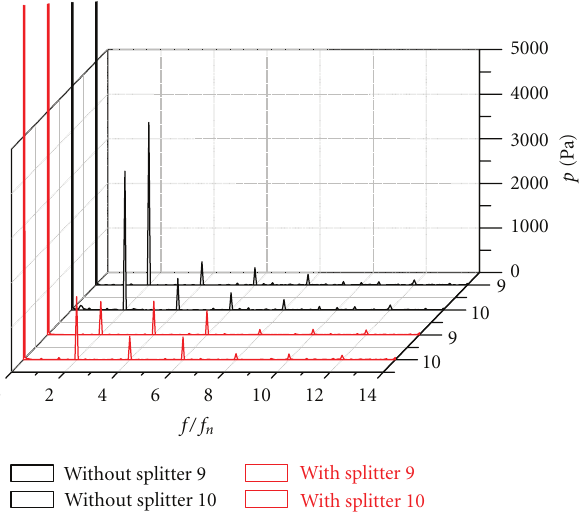
Figure 11: Frequency domain of pressure pulsation at outlet pipe monitoring